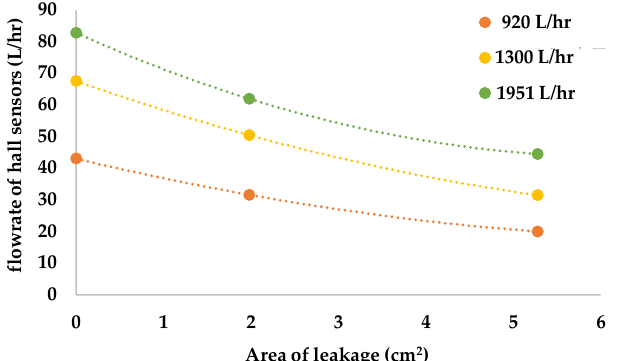
Figure 11. Variation of flowrate of hall sensors with respect to different size of leakage, for different flowrate in the pipeline.